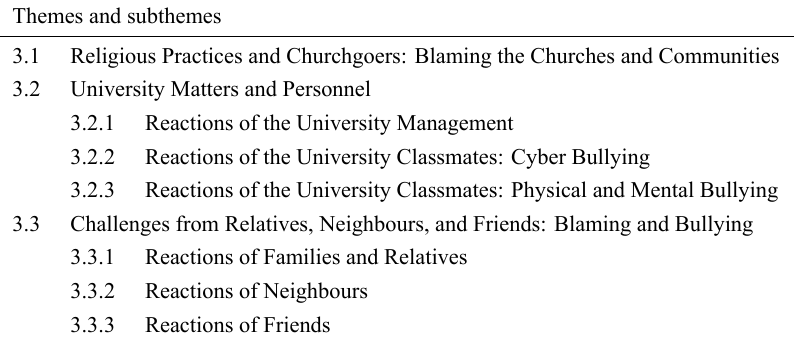
Table 1. Themes and